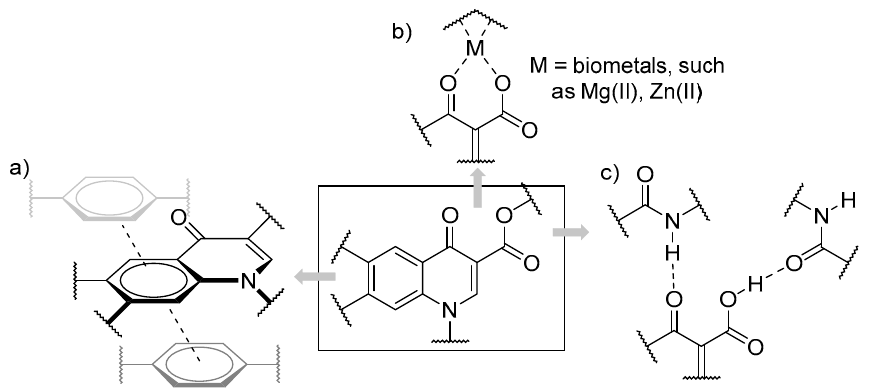
Figure 2. 4-Quinolone motif and possible intermolecular interactions with biomolecules. ( a ) π - π Stacking interactions. ( b ) Chelating property with biometals. ( c ) Hydrogen